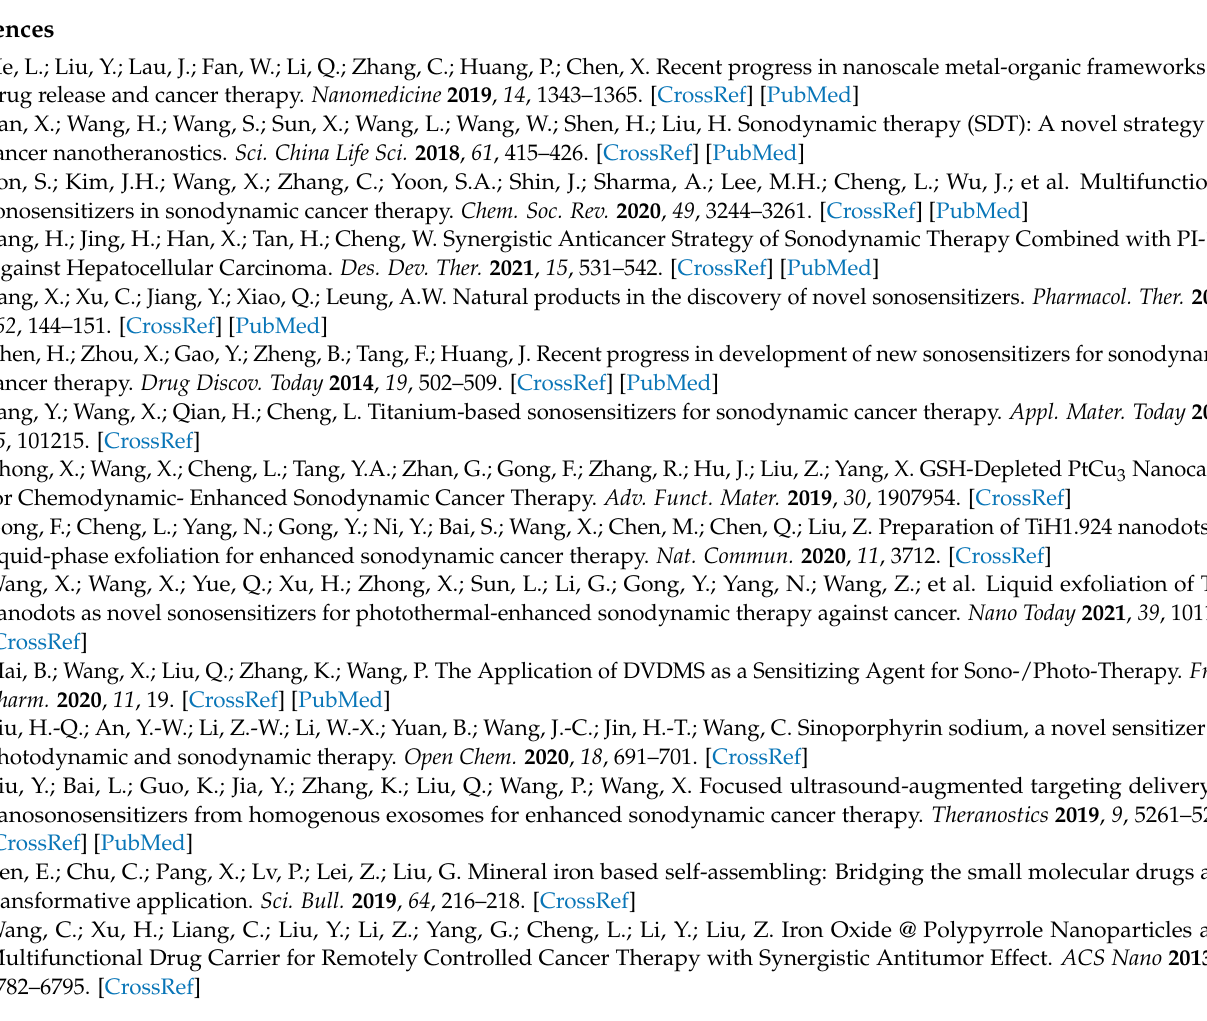
study of the organs harvested from mice with different treatments at 12